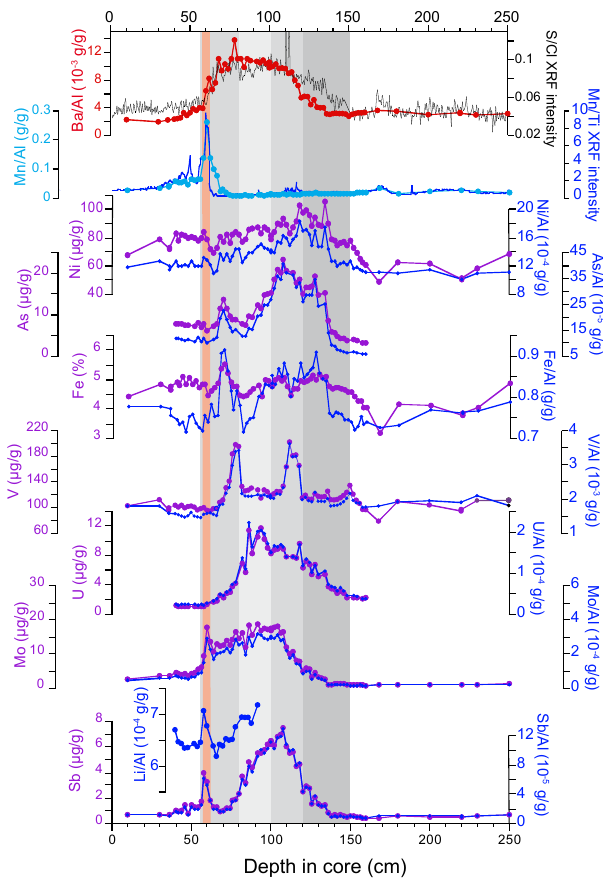
Figure 3. The elemental concentrations and the element / Al ra- tios for the bulk sediment of MD04-2722 as a function of depth in core, together with the S / Cl XRF intensity. Dark and light grey bands indicate the S1 layer determined from Ba enrichment (55– 120cm) and the interval of low grayscale values (80–100cm), re- spectively. The darkest grey band and the orange band indicate the interval affected by downward sulfidization (Passier et al., 1996) (120–150cm) and Mn enrichment (56–60cm),